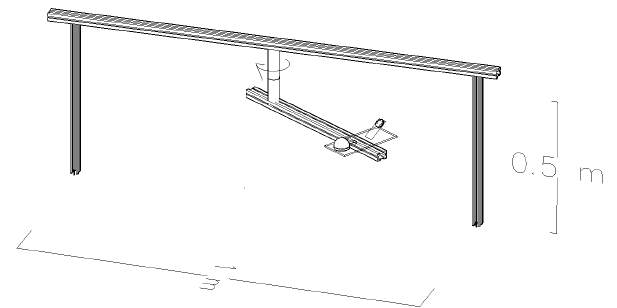
Fig. 4. Rotating machine used to simulate car speed, with two opti- Figure 4. Rotating machine used to simulate car speed, with two optical sensors placed on 3 cal sensors placed on the the device 4